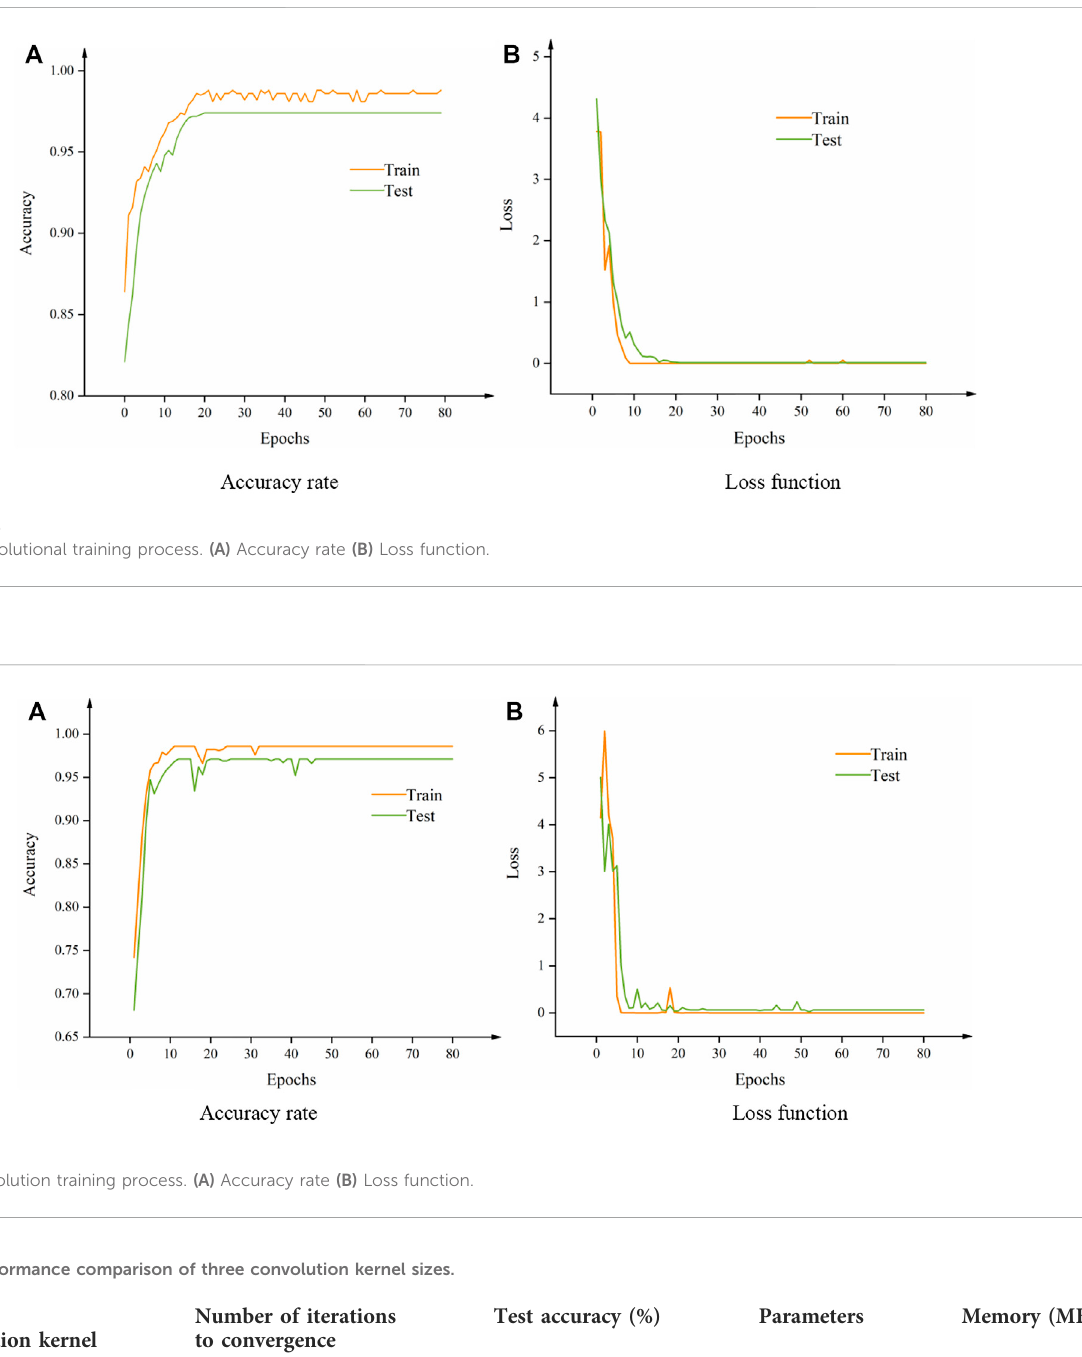
Test accuracy (%) Parameters Memory